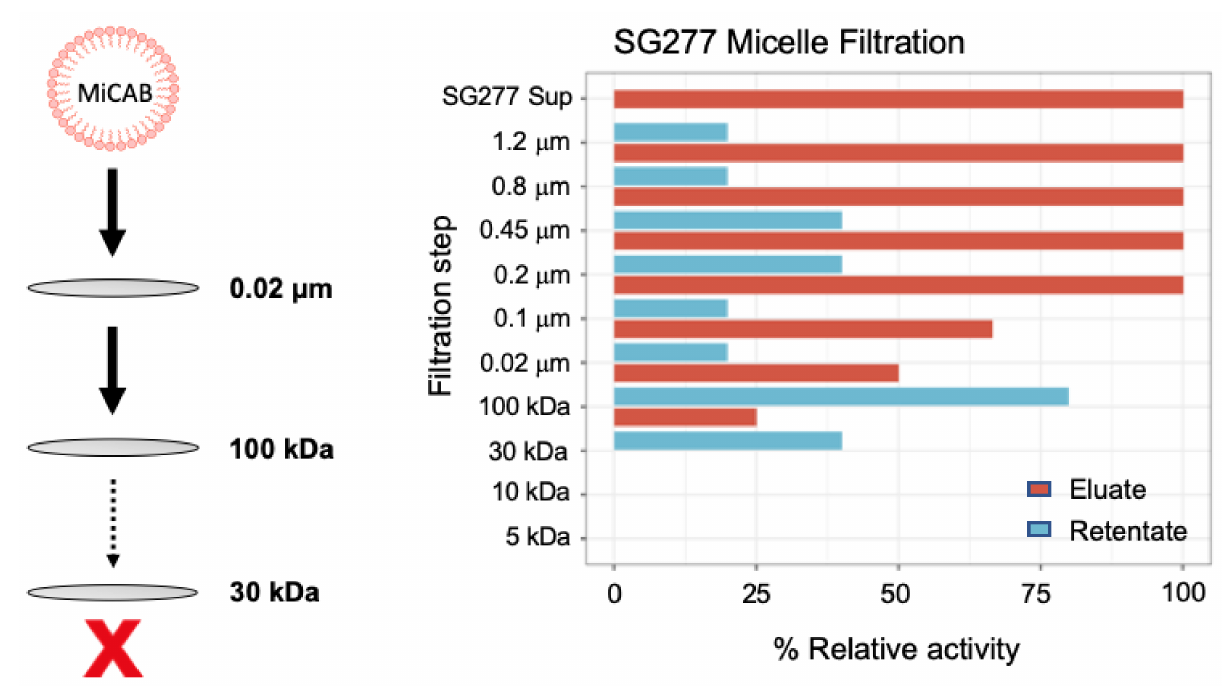
Figure 4. Activity is associated with micelles. Schematic diagram showing the Bacillus micelles and the step-wise filtration steps. The graph shows the resulting anti-CD630 activity in the eluate and retentate following filtration of an SG277 culture supernatant through a series of filters starting with 1.2 µ m and ending with a 5 kDa MWCO membrane. Inhibitory activity to CD630 was determined using a microdilution assay and the data is the mean of 4 independent